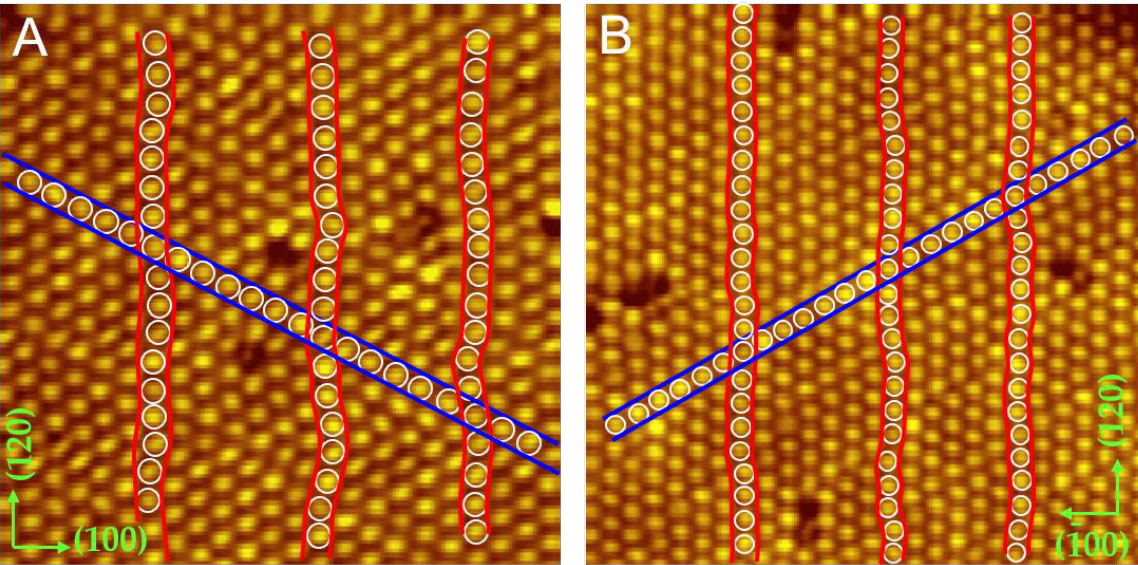
Figure 2. Wavy structure of the C 60 submonolayer driven by compressive strain. ( A ) A wavy domain showing the wavy arrangement in the (120) direction, and the straight arrangement in the (1 1 ̅ 0) directions, 0.9 V, 20 × 20 nm. Both directions √ correspond to the 3 directions of the Cd(0001) surface. ( B ) Another domain showing the wavy alignment of C 60 molecules, 0.4 V, 22.7 × 22.7 nm. The direction of straight alignment has an angle of 60 degrees with respect to that in (A).